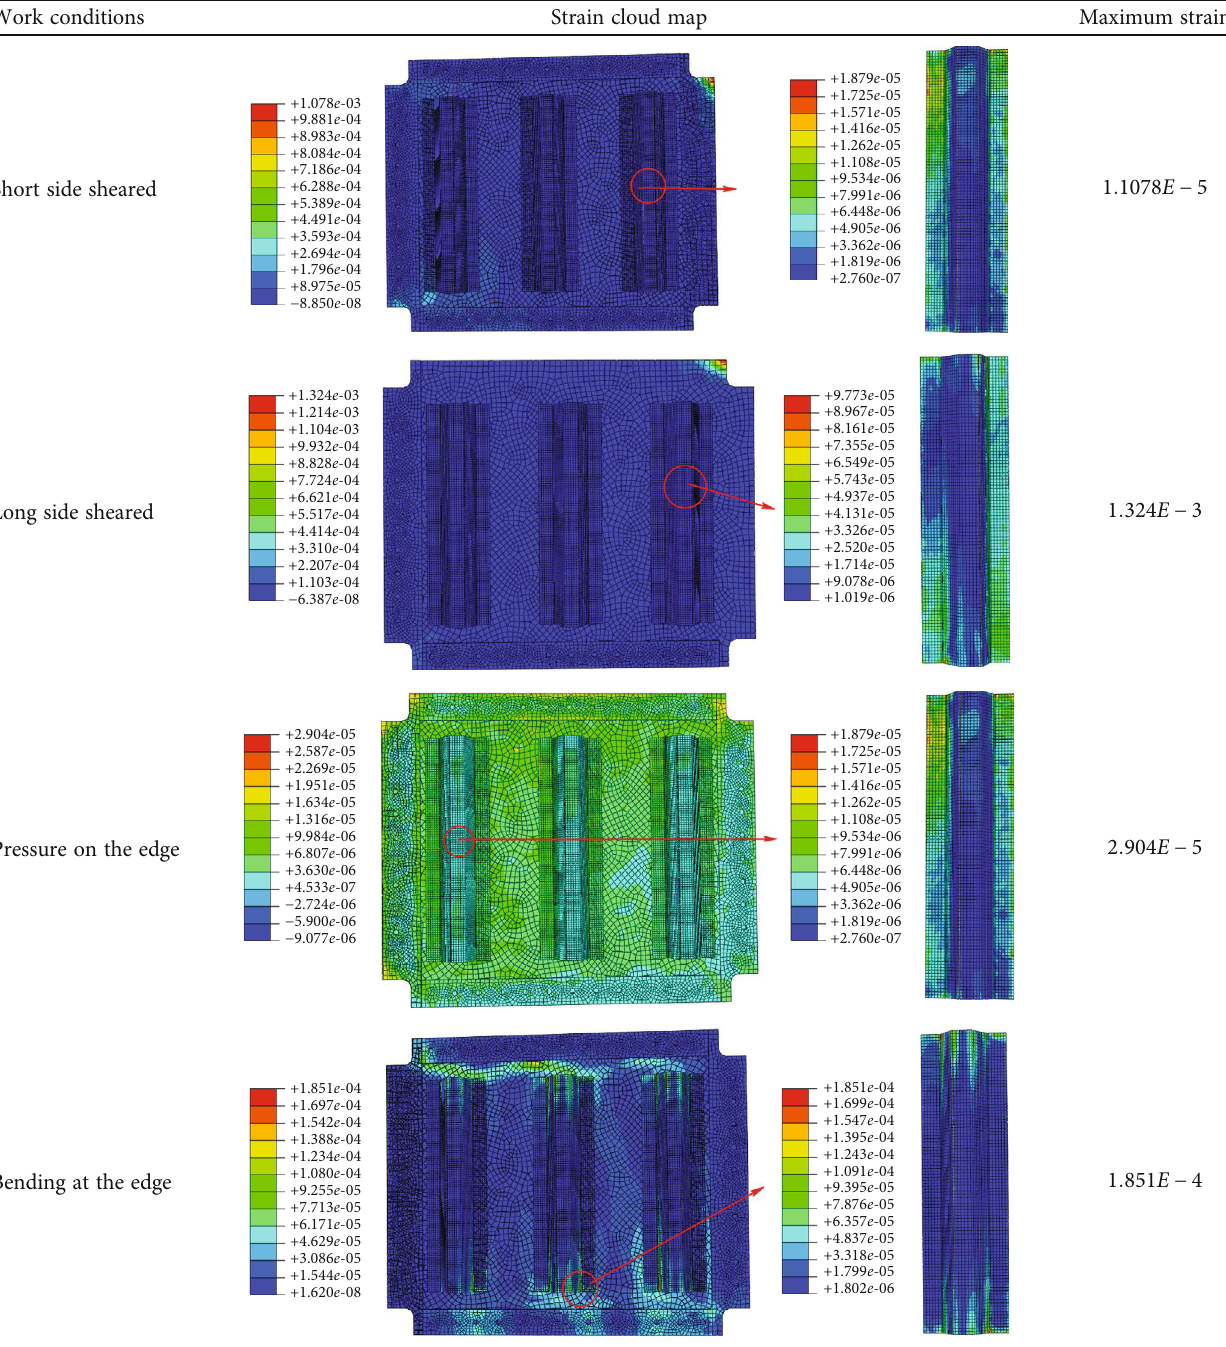
Table 8: Strain cloud under typical static